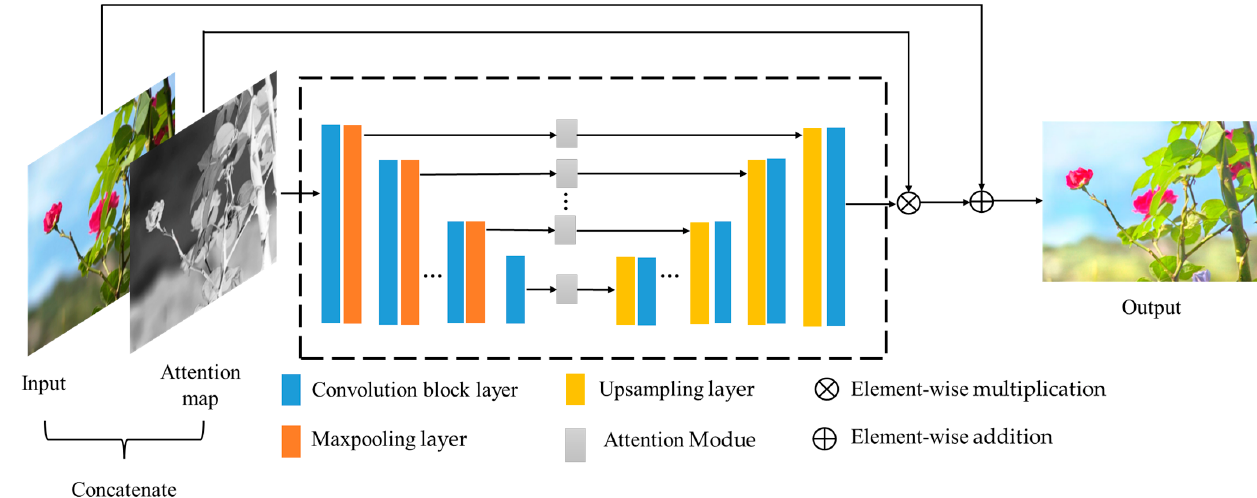
Figure 3. Flowchart of the EnlightenGAN algorithm.